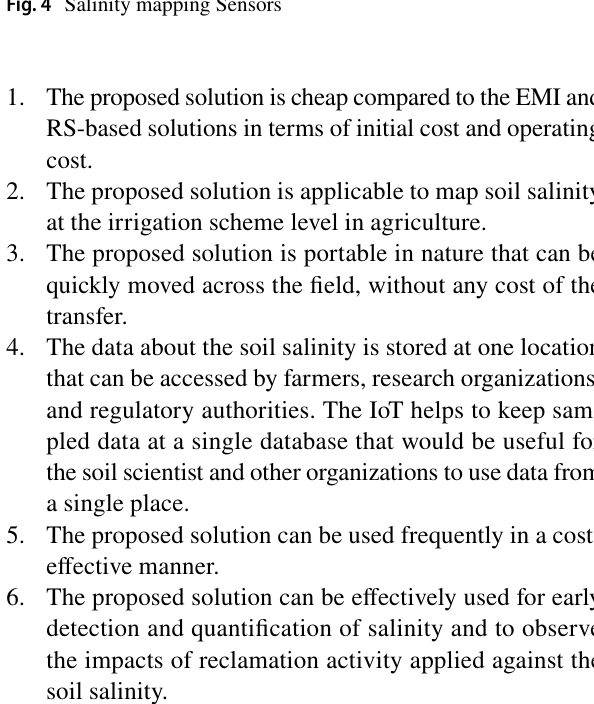
Fig. 4 Salinity mapping